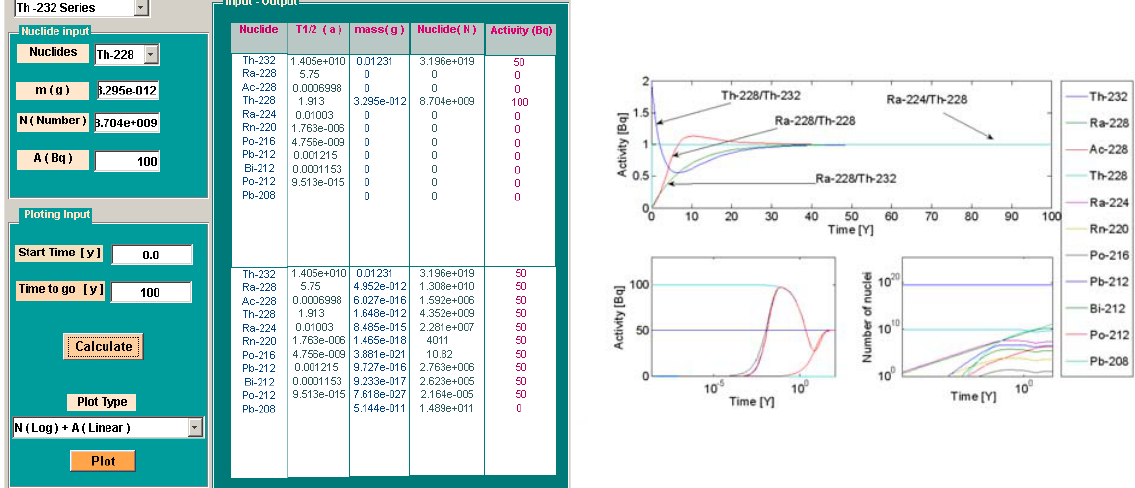
Fig. 6 Exploration of the 232 Th decay chain when decay starts with 232 Th and 228 Th. Initial activities are 50 Bq and 100 Bq, respectively. Decay time is 100